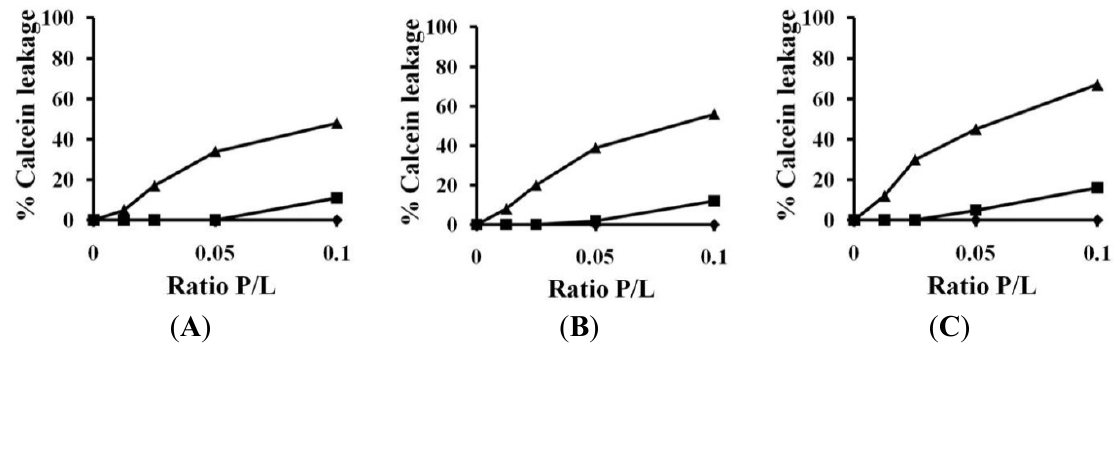
Figure 3. Percent leakage of calcein from ( A ) PC; ( B ) PC:SM (2:1, w / w ); and ( C ) PC:CH (2:1, w / w ) was measured for 25 min after the addition of various doses of